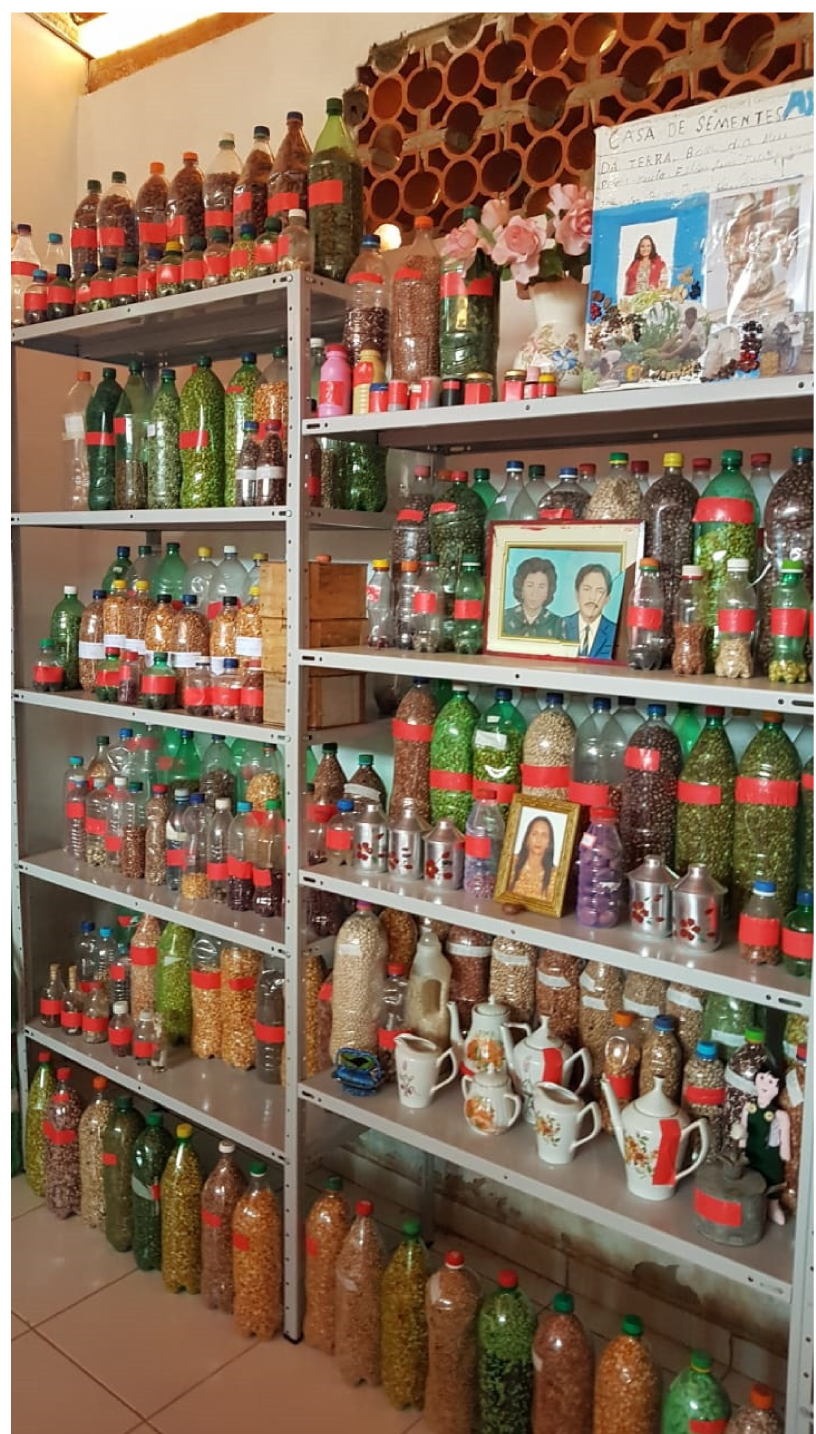
Figure 6. Community Seed Bank. Photo credit: Semi-arid Agrobiodiversity Management Program and Agrobiodiversity of the Semi-arid Project image bank, Bom Jesus da Lapa, Bahia, Brazil, October